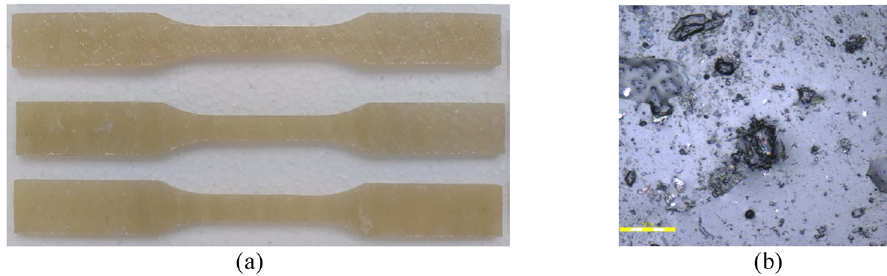
Figure 4: View of samples without the addition of recyclate ( a ) and structure of the K0 composite at magni fi cation 50 × ( b ) .